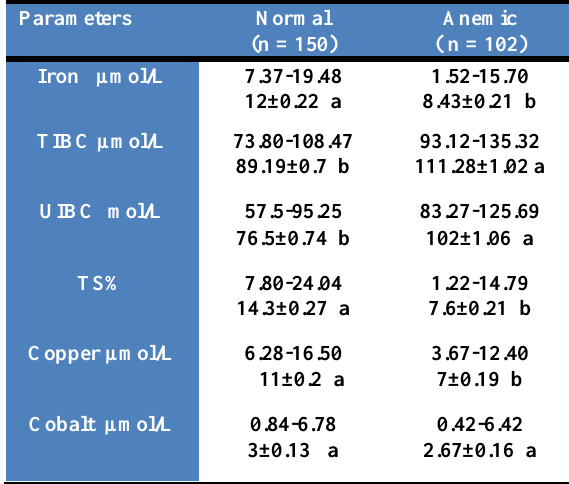
Table, 1: The biochemical parameters in clinically normal and anemic camels; ranges and means ±